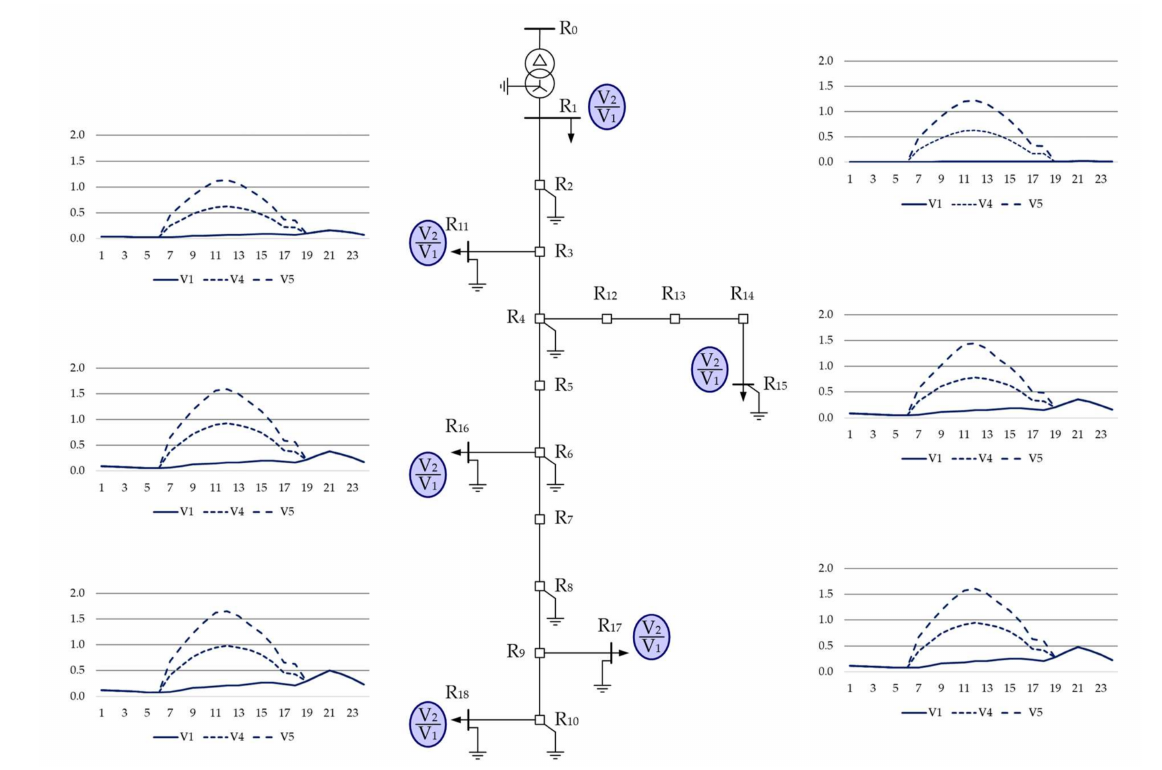
Figure A15. Daily simulation results for variants V1, V4, and V5: negative sequence component of bus voltage (%).